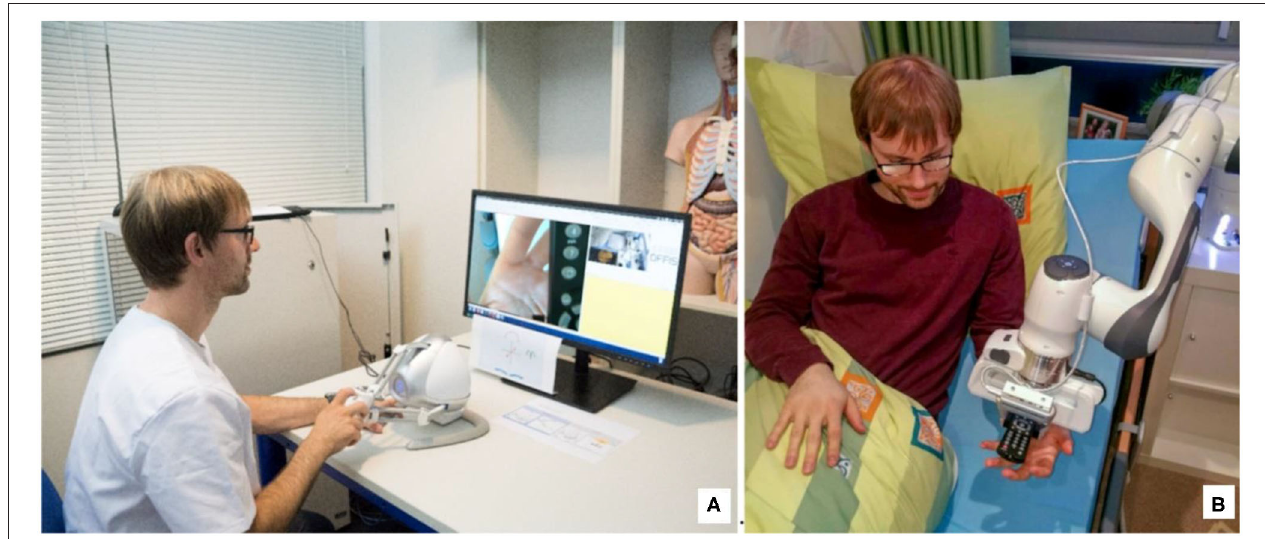
FIGURE 1 | Vision of telemanipulation in outpatient care: (B) the patient lies in his bed and receives support from the nurse (A) with the help of the telemanipulated robotic arm, in this case, the remote control that had fallen out of the bed and which he could no longer reach